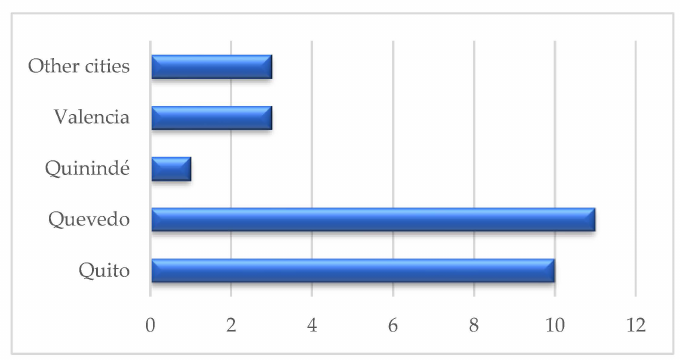
Figure 8. Respondents’ cities of residence.